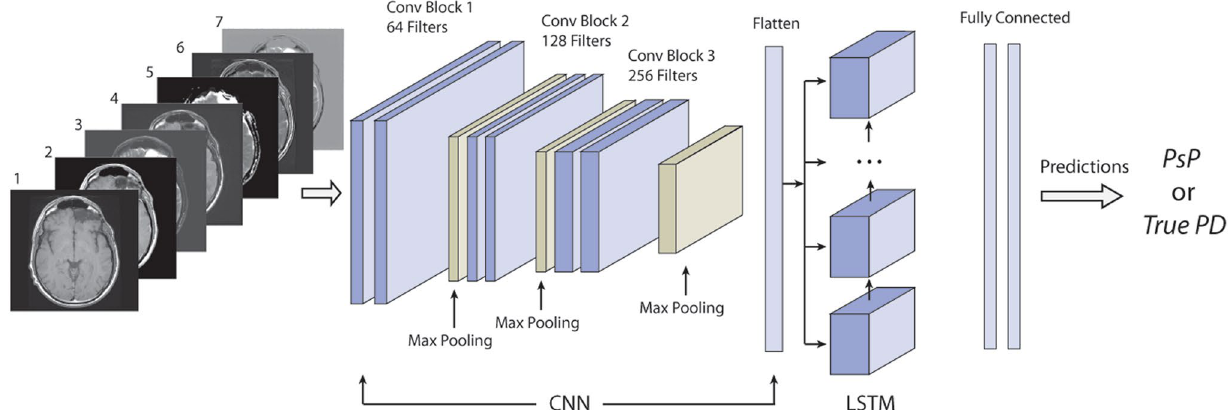
Figure 5. CNN-LSTM architecture with a set of multiparametric MRI sequence input consisting of (1) T1pre, (2) T1post, (3) T2, (4) FLAIR, (5) ADC map, (6) T1post–T1pre, and (7)